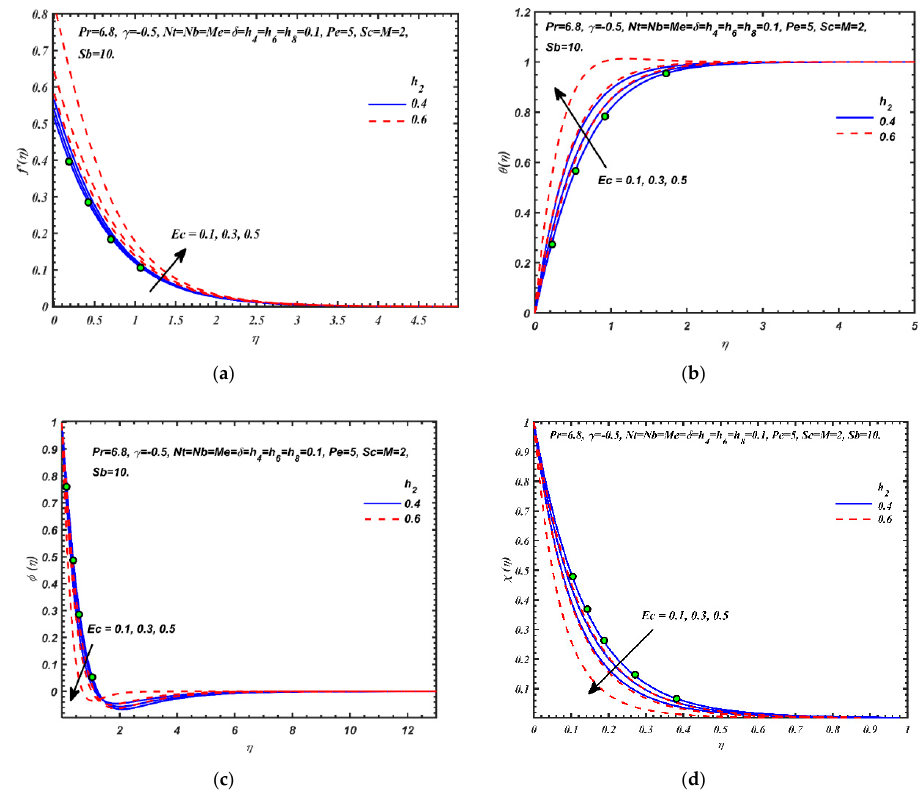
Figure 2. Influences of h 2 and Ec on the dimensionless: ( a ) velocity, ( b ) temperature, ( c ) nanoparticle volume fraction, ( d ) micro-organism density number function.